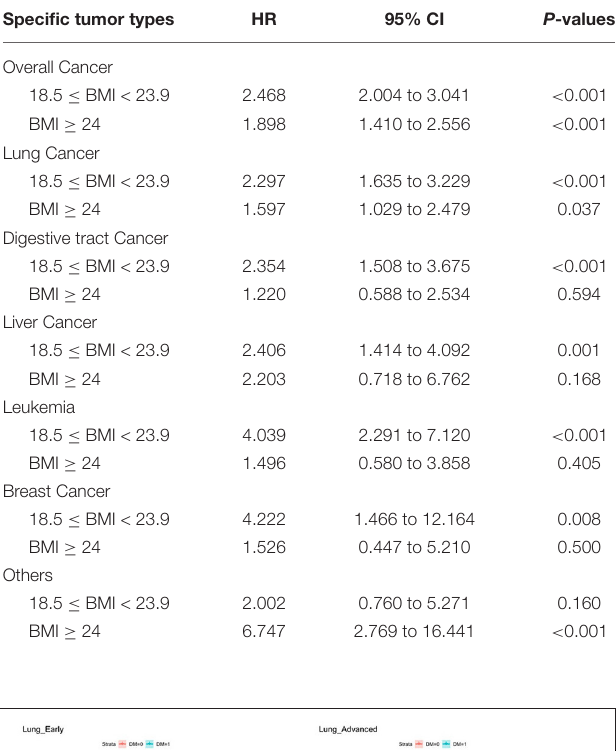
TABLE 5 | Hazard risk for all cancers mortality in patients with diabetes stratified by BMI (kg/m 2 ). Specific tumor types